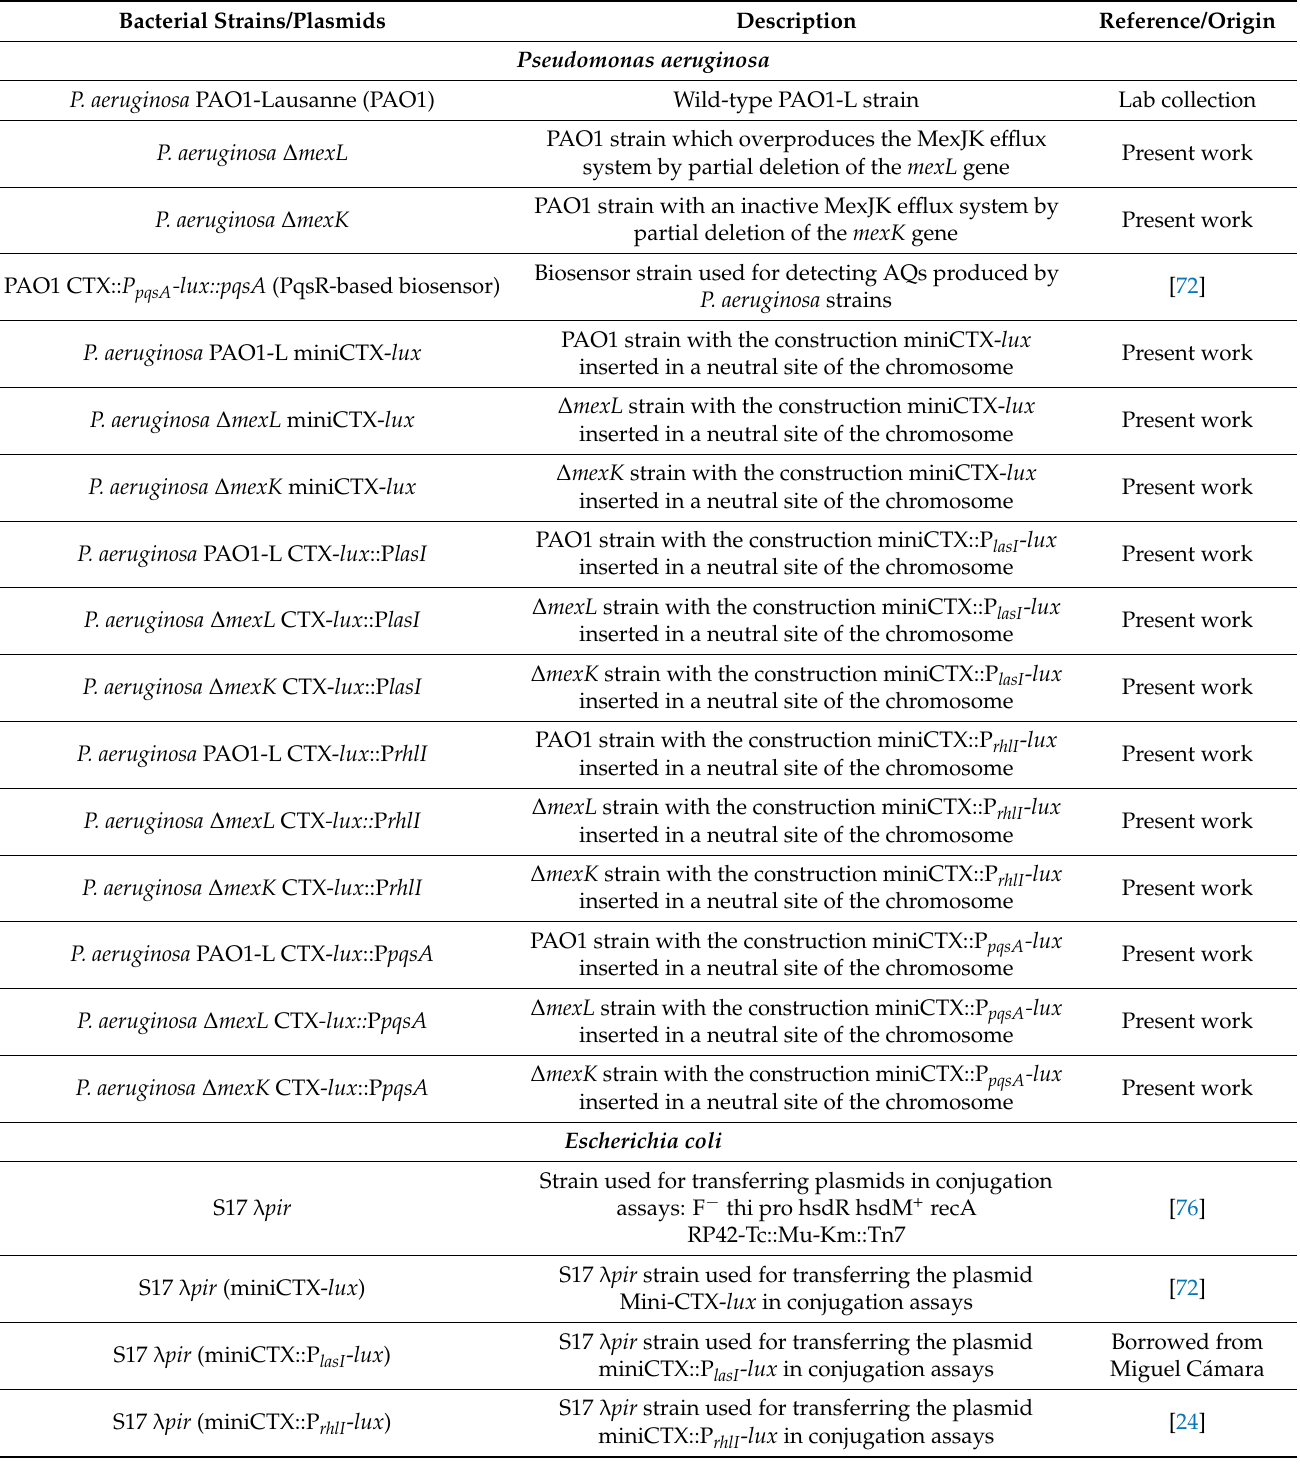
Table 2. Bacterial strains and plasmids used in this